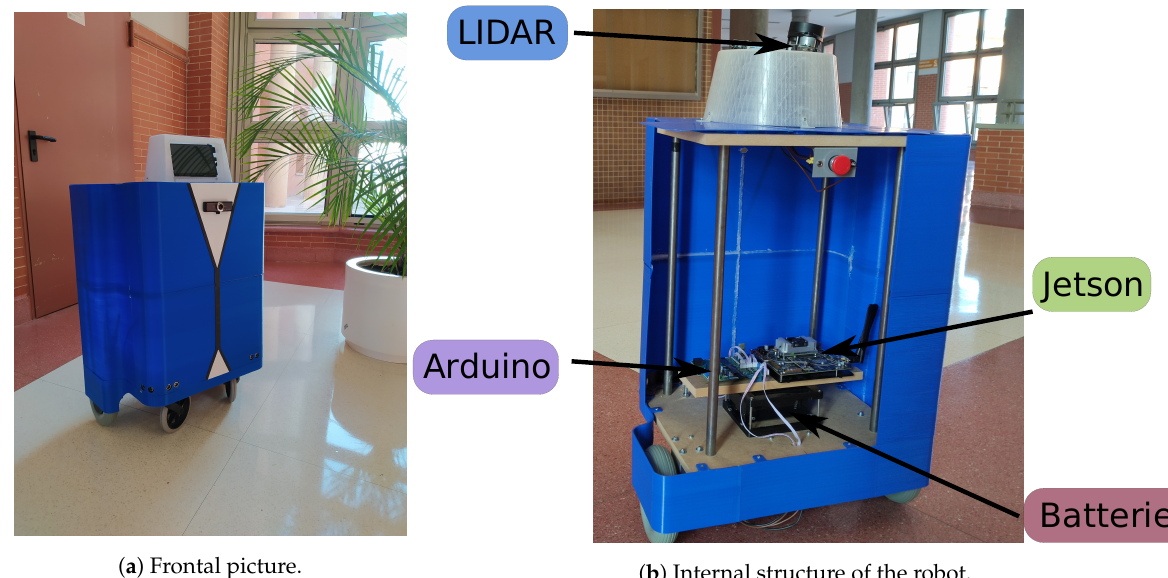
Figure 1. Pictures of our low-cost robotic platform. We show both a frontal picture and the internal structure, where it is possible to observe all the electronic and mechanical components of the